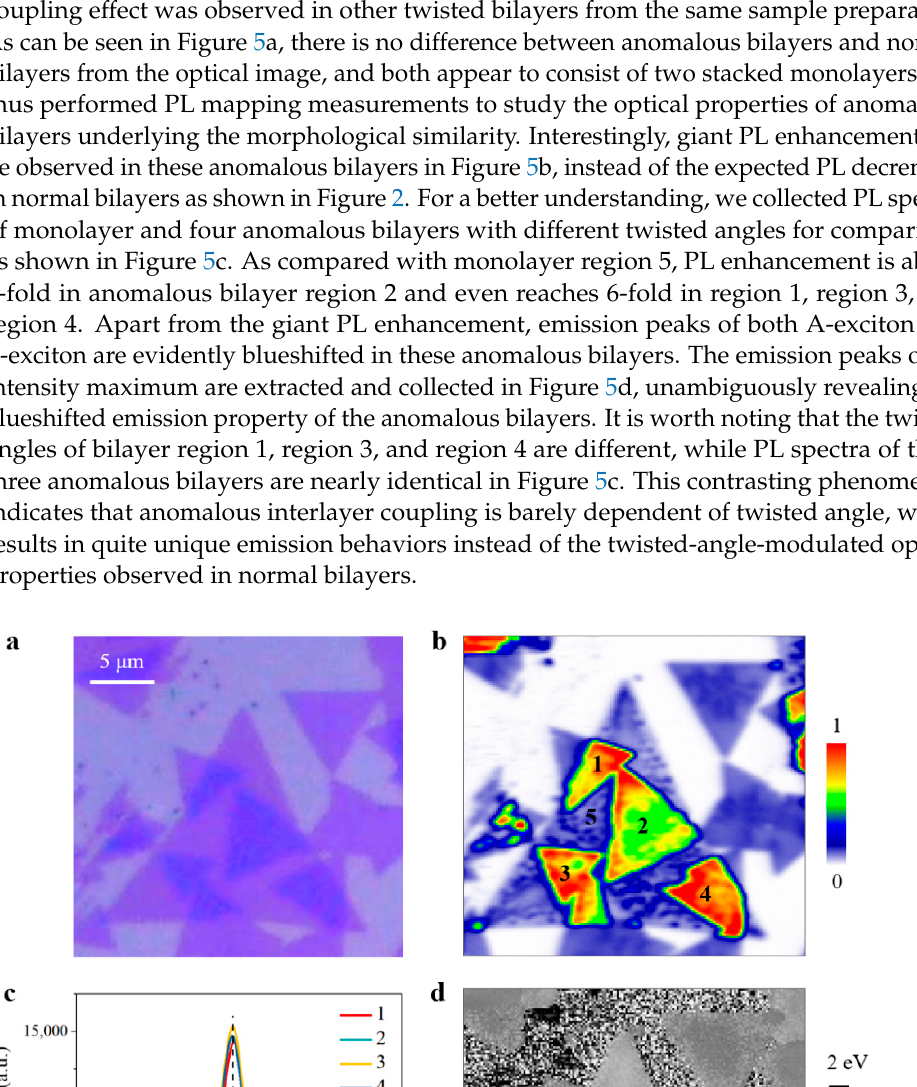
Figure 4. Raman spectra of twisted MoS 2 bilayers. ( a ) Raman signals of out-of-plane 𝐴 (cid:2869)(cid:3034) and in- plane 𝐸 (cid:2870)(cid:3034) vibration modes in prototypical monolayer and twisted bilayers. ML, monolayer. ( b ) Raman interval of 𝐴 (cid:2869)(cid:3034) and 𝐸 (cid:2870)(cid:3034) vibration modes. BL, normal bilayer.